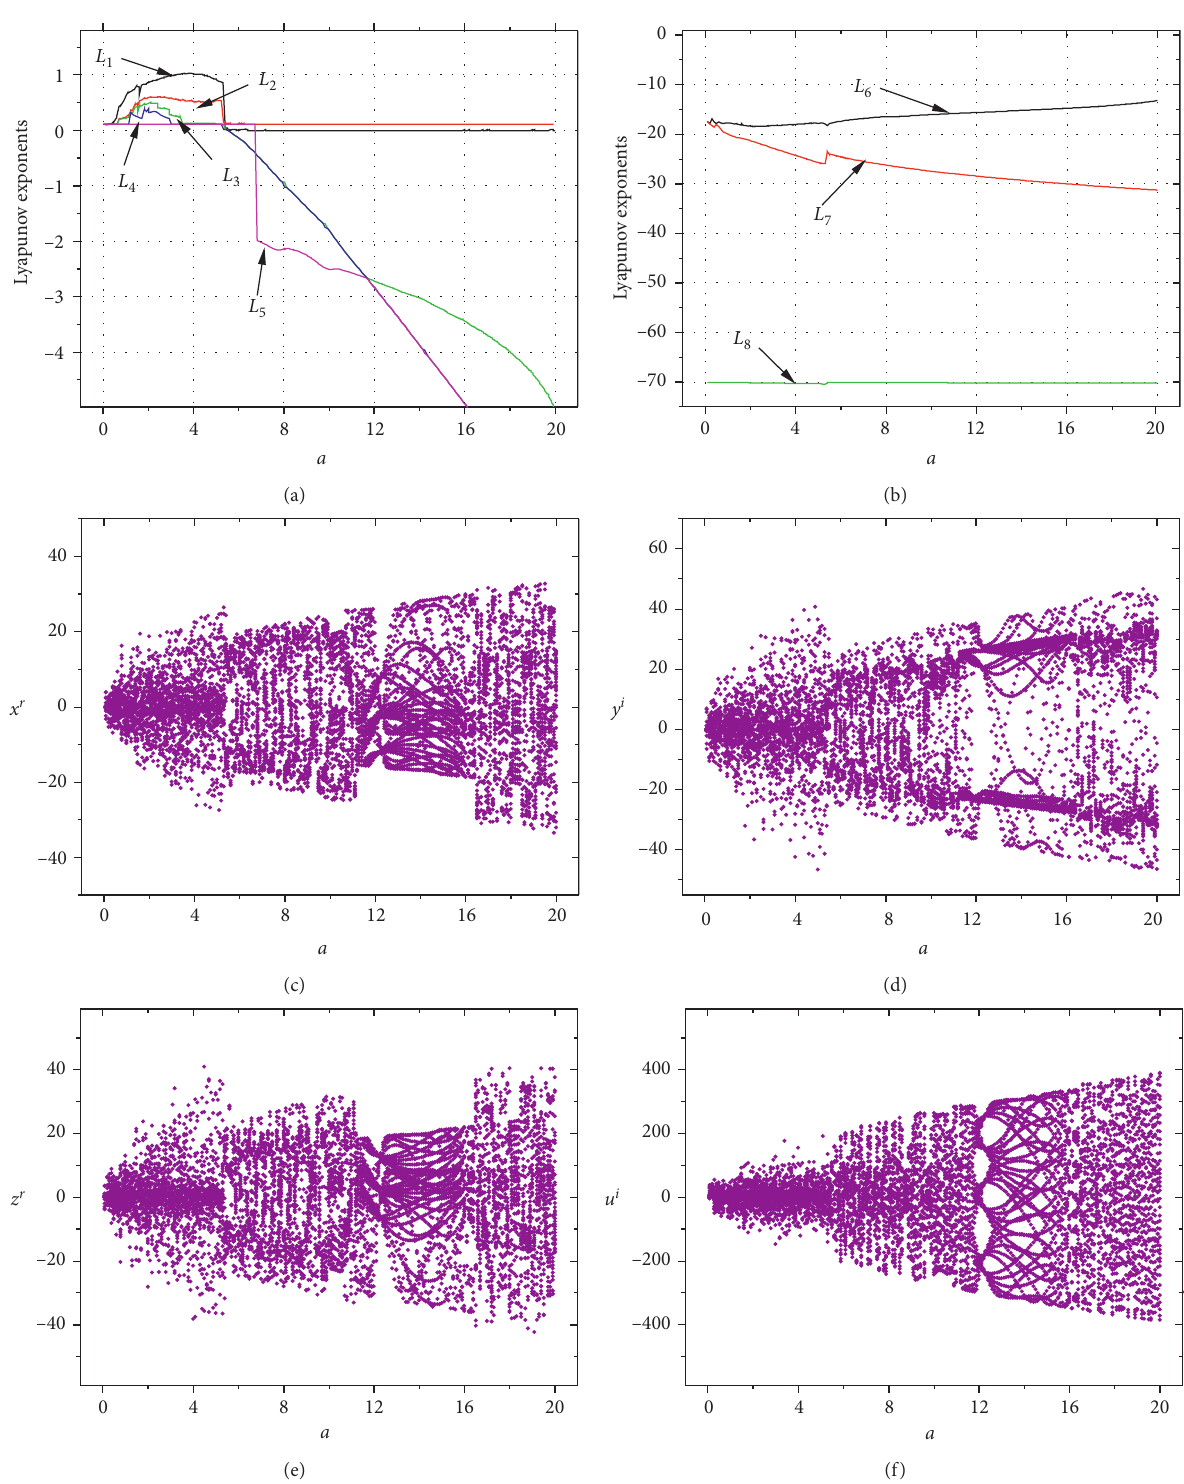
Figure 1: When b � 12 ,c � 20 ,d � 3 ,h � 10and ,a ∈ [ 0 , 20 ] with the primary positions ( x r ( 0 ) , x i ( 0 ) , y r ( 0 ) , y i ( 0 ) , z r ( 0 ) , z i ( 0 ) , u r ( 0 ) , u i ( 0 )) � ( 1 , 2 , 3 , 4 , 5 , 6 , 7 , 8 ) . (a) LEs of system (2): L in ( a, x r ) . (d) Plane bifurcation diagrams ( a, y i ) . (e) Plane bifurcation diagrams ( a,z r ) . (f) Plane bifurcation diagrams ( a,u i )